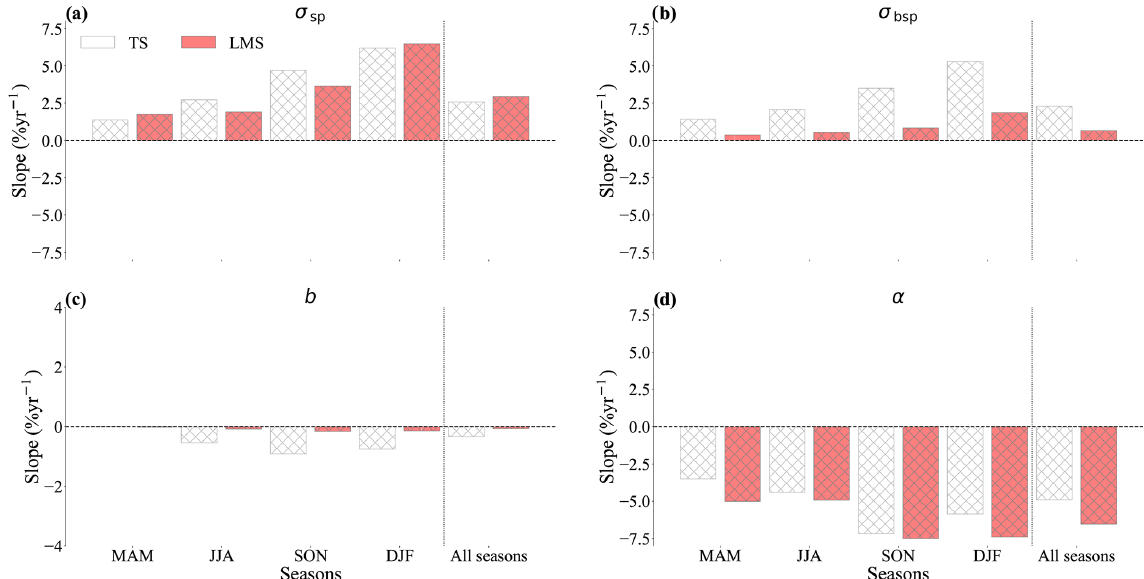
Figure 2. Relative trends based on daily medians for (a) the particle light scattering coefficient, (b) the particle light backscattering coefficient, (c) the hemispheric backscattering fraction (note the different y scale), and (d) the scattering Ångström exponent for different and all seasons. The white bar displays the Theil–Sen estimator (TS). The red bar displays log-transformed least mean square (LMS) trends. Cross-hatching denotes trends that have statistical significance (ss) at a confidence interval of 95%. The ss for the TS is based on the “pre-whitened” (PW) time series. The trends in their respective unitsyr − 1 are in the tables in the Supplement. The dashed line aids the reader in separating the individual seasonal trends and the trend with all the seasons